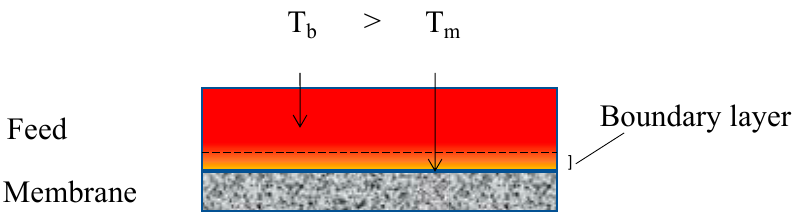
Figure 1. Temperature difference at the feed side, due to the boundary layer resistance. An increase of the feed flow rate and/or the realization of modules with baffles/turbulence promoters could enhance the turbulence inside the module, thus reducing the boundary layer resistance [11–14]. However, pressure drops must be carefully controlled, in order to not overcome the liquid entry pressure value of the membrane with a consequent wetting of micropores. On the other hand, the temperature reduction caused by the water evaporation could not be avoided by the above strategies. Recently, the possibility of applying localized heating was investigated as a new approach to enhance the thermal performance of MD through the reduction of the temperature polarization at the feed side. In particular, both the heating inside the module and the direct heating of the membrane surface were studied. In the first case, heat was supplied to the module, without changing the membrane properties, while in the second case the membrane itself was also modified. Both approaches had the aim of increasing the temperature of the feed at the membrane surface, thus enhancing the water evaporation and the permeate production. By acting on the temperature close to the membrane surface, the cooling effect of the evaporation can also be better compensated. Solar and electrical energy sources were used to provide heat. Research in the field has significantly increased in last years and in this contribution,